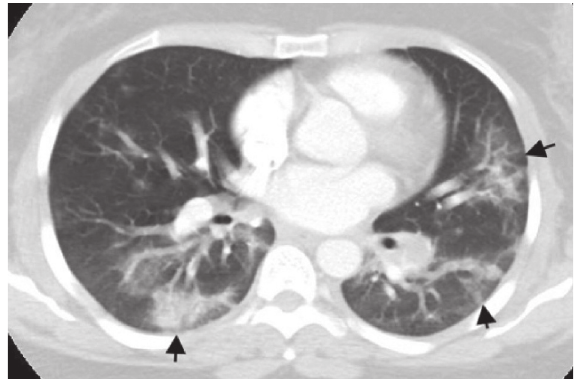
Figure 5: Chest axial CTA image on a lung window shows bilateral multifocal peripheral, lower zonal predominant ground-glass opacities to consolidations (black arrows).